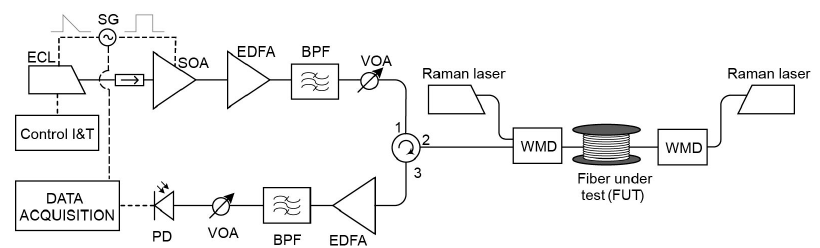
Figure 17. Experimental setup used for the measurements of this section, based on that of the initial CP- Φ OTDR demonstration [10]. ECL: External cavity laser; SG: Signal generator: I&T: Intensity and temperature; SOA: Semiconductor optical amplifier; EDFA: Erbium doped fibre amplifier; BPF: Band-pass filter; VOA: Variable optical attenuator; WDM: Wavelength division multiplexer; PD: Photodetector. Solid line represents optical path, dashed line represents electrical path.